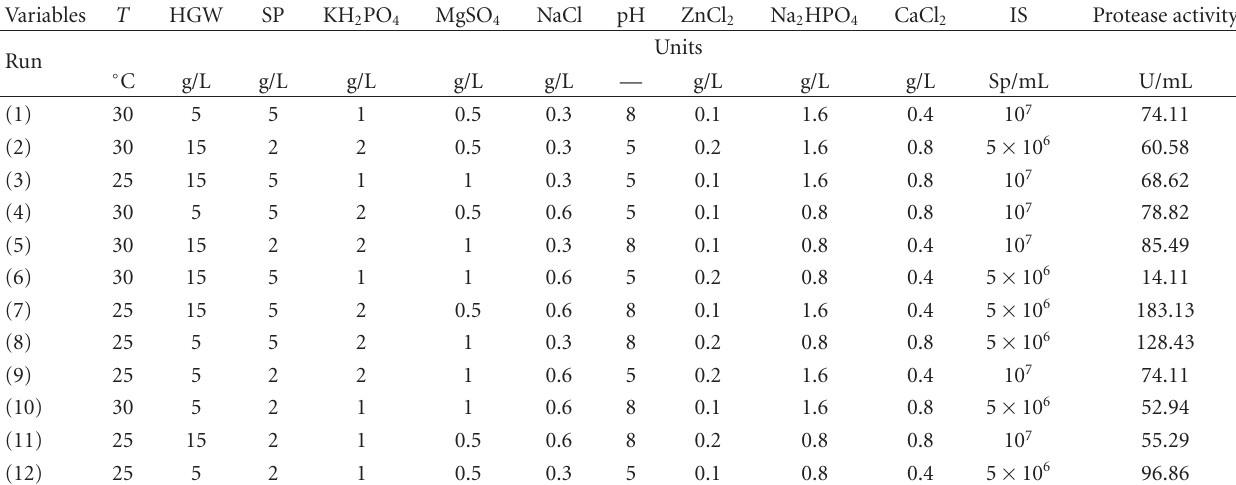
Table 2: Plackett-Burman experimental design matrix with proteolytic enzymes production levels.